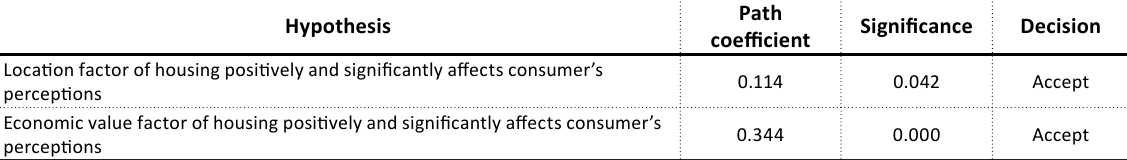
Table 16. Hypotheses